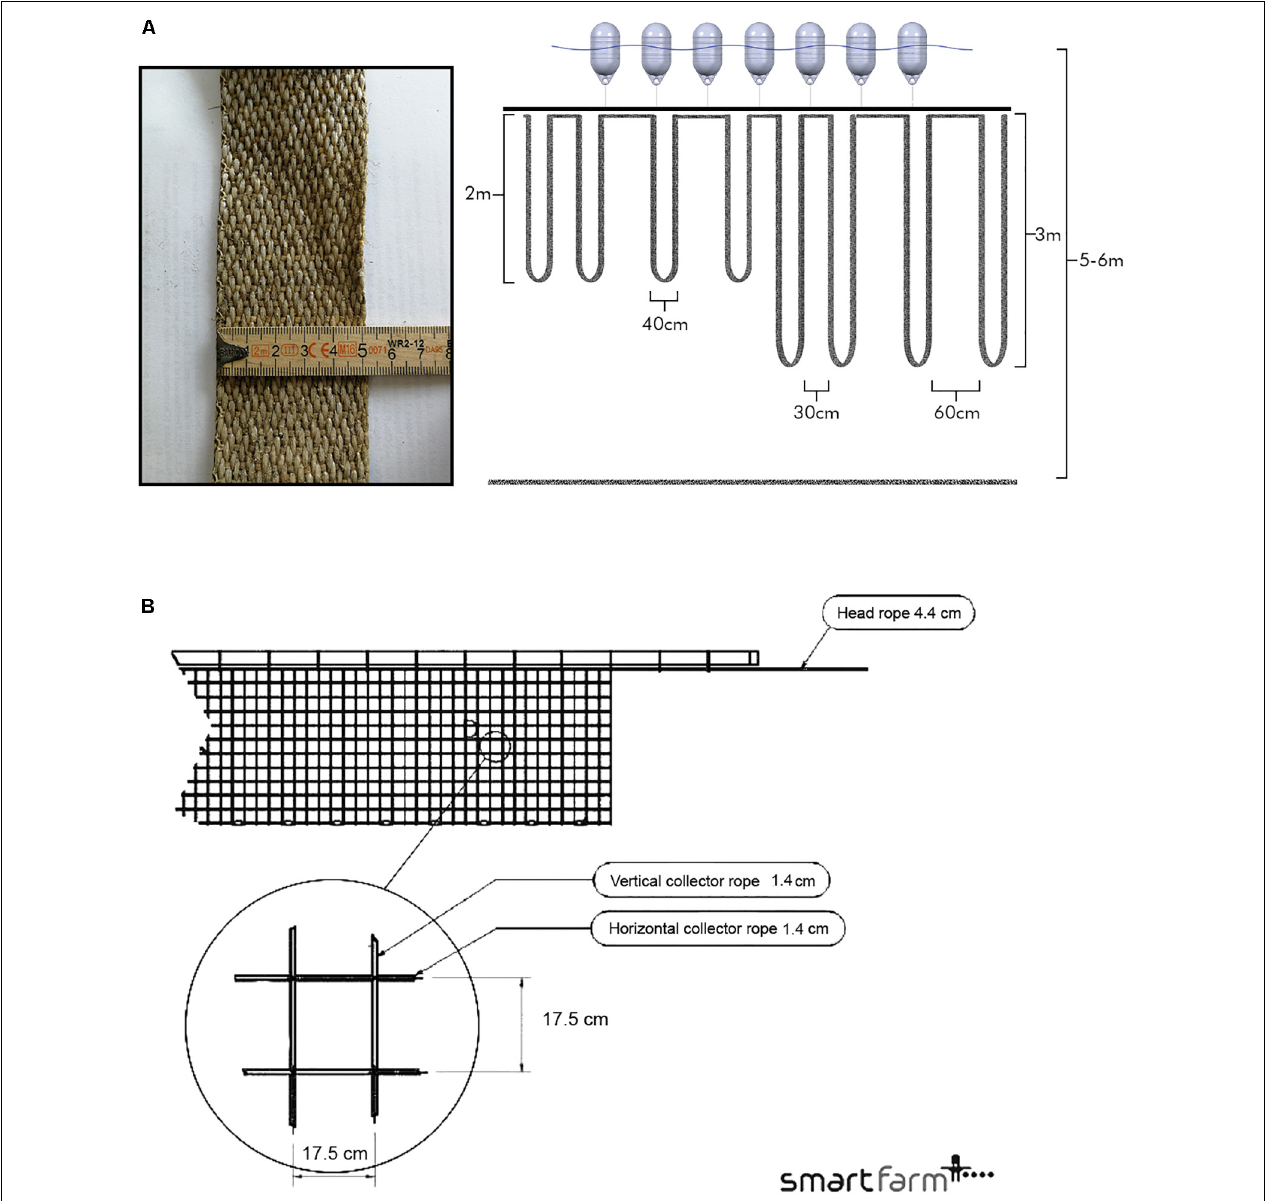
FIGURE 2 | (A) Schema of the belt spat collector treatments and example of the substrate material (left). Loop spacing on the mainline was tested at 30 and 60 cm between loops; loop length from the mainline was tested at 2 and 3 m. Loop width is set at 40 cm. Treatments were established to fill a complete line (SKIV, SALL) or split on a line so that one line had two treatments (DV). Spat collectors are suspended from a mainline with 20 L buoys and concrete blocks (not illustrated here) for buoyancy maintenance. The water surface and sediment surface are represented in a 5–6 m deep water column. (B) Schematic of a 17.5 cm × 17.5 cm tube-net. The net is suspended from an air-filled polyethylene tube, and a head